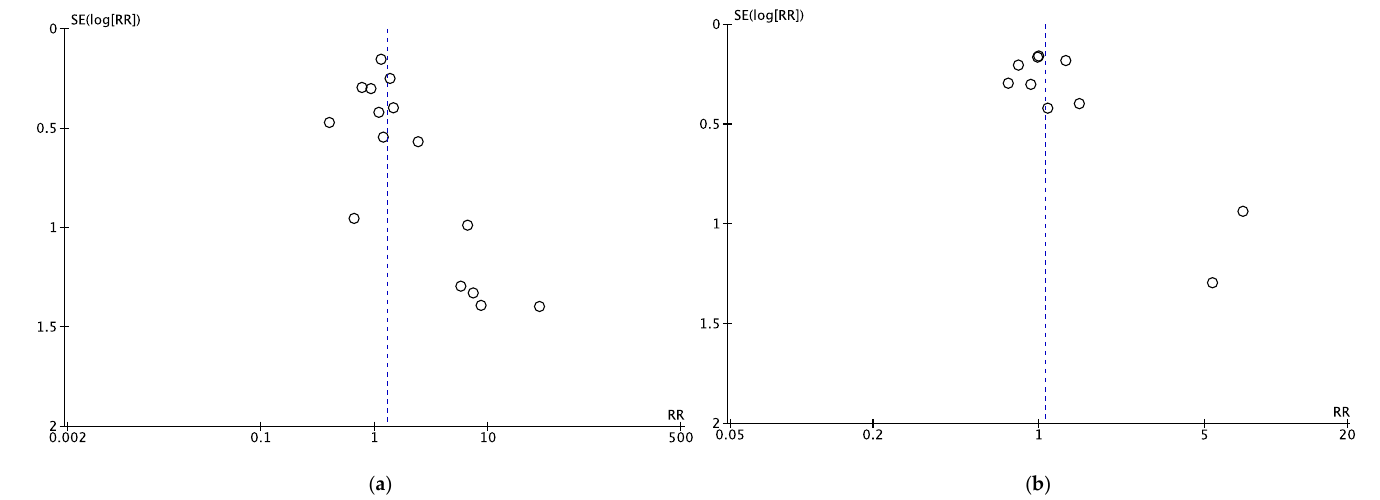
Figure 12. Funnel plots of AIH-PBC studies meta-analyzed to compare ( a ) biochemical improvement and ( b ) transplant-free survival among patients treated with UDCA vs. combination therapy. UDCA = ursodeoxycholic acid and combination therapy = UDCA + [corticosteroids and/or antimetabolites].